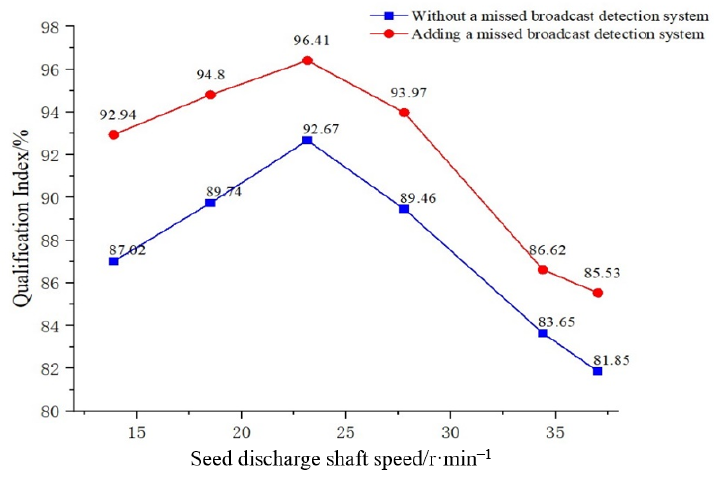
Figure 16. Analysis chart of field test results.